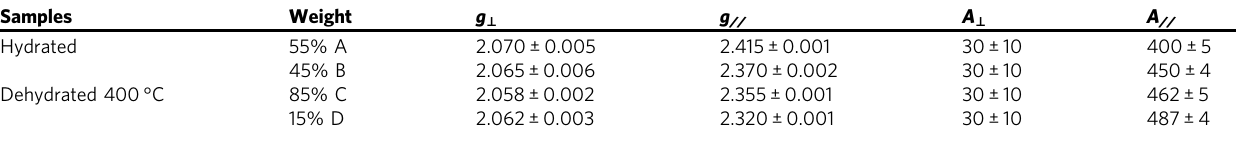
Only the absolute values of the hyper fi ne components are extracted from the spectra. Hyper fi ne couplings are given in units of